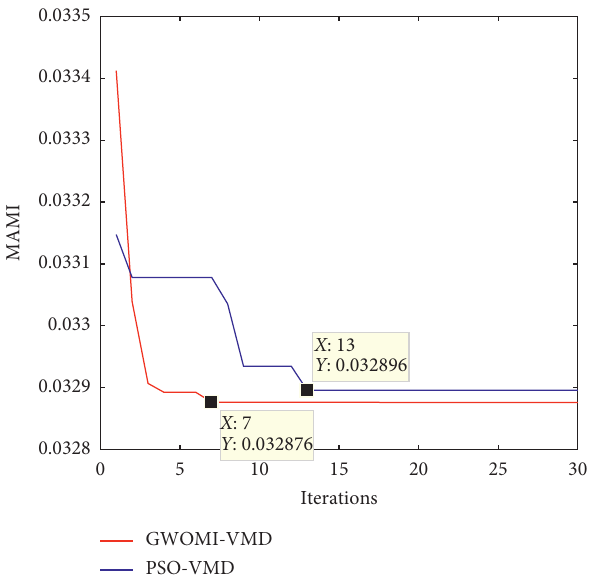
Figure 10: Convergence curves of GWOMI and